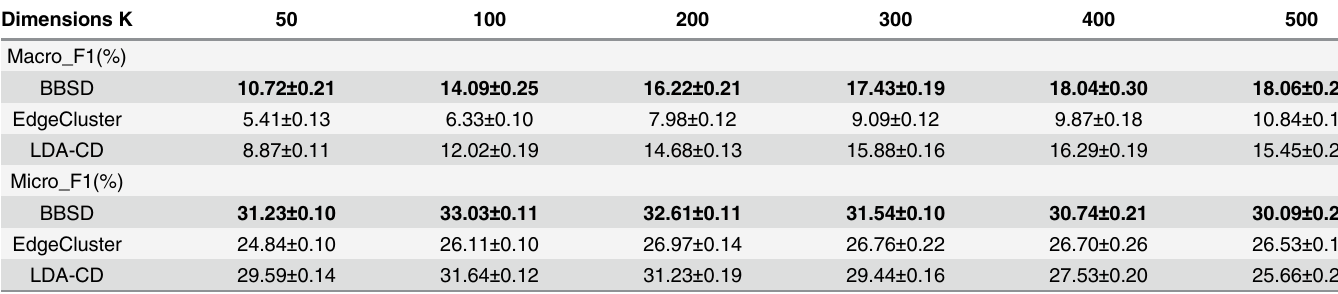
Table 7. Parameter sensitivity to social dimensions on Flickr (LP = 9%).